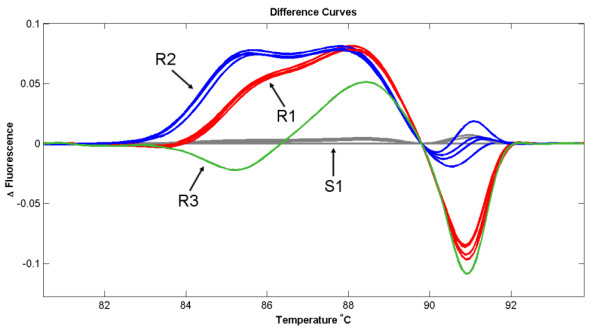
The differences in shapes of melting curves illustrate the detection of four homoduplexes corresponding to haplotypes R1, R2, R3, and S1. For example, the haplotype R1 was detected in iceberg cv. Salinas, haplotype R2 in primitive romaine-like accession PI491224, R3 in L. serriola accession UC96US23, and S1 in romaine cv. Valmaine.